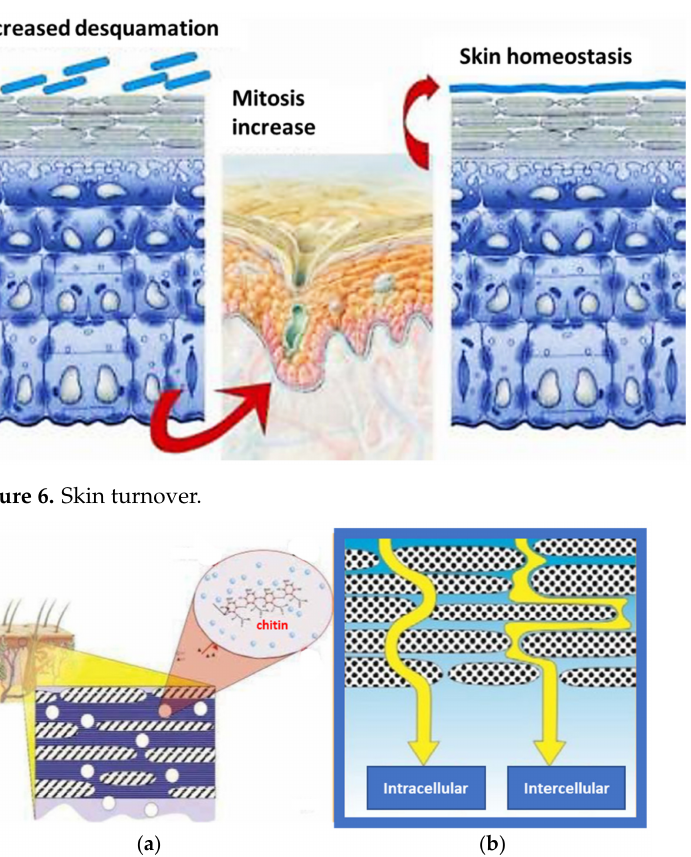
Figure 5. Skin structure ( a ) and corneocytes organized by lipid lamellae ( b ). The major cellular component of the epidermis includes keratinocytes, which, at the end of the skin turnover, forms an overlapping structure made by non-living cells, the corneocytes, bridged together by specialized junctions, named corneodesmosomes (Figure 6) [96–98]. However, keratinocytes, held together by desmosomes, provide cell-to- cell adhesion while corneocytes enveloped together by lipid layers (i.e., Lipid lamellae) con- tribute to the structure and function of SC (Figure 7) [96–98]. Therefore, the SC thick layer is able to adsorb three times its weight in water, is basically represented by a two-compartment system composed of vertically stacked cells, the corneocytes, which, filled with keratin filaments and enclosed in a membrane envelop of protein and lipids, are released from lamellar bodies within the epidermis during the skin turnover (Figure 6) [96–98].